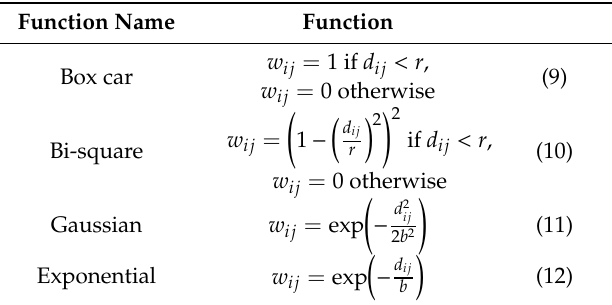
Table 3. Kernel function equations.